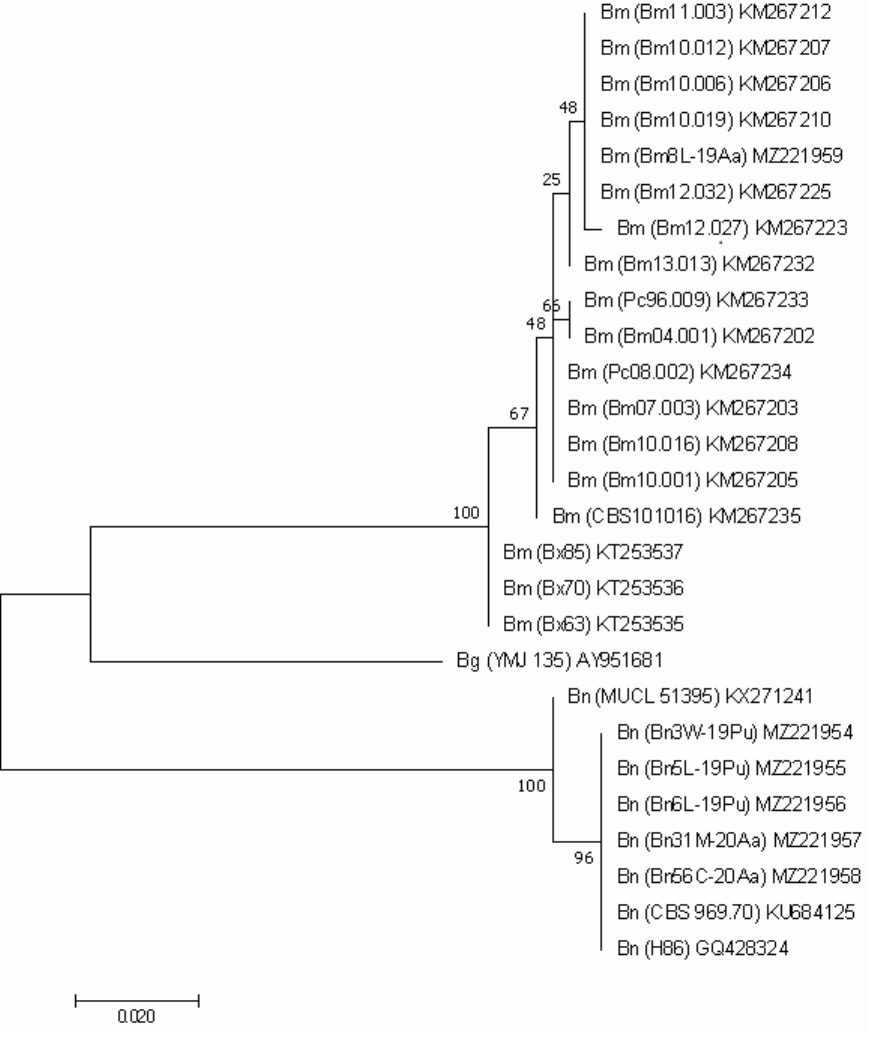
Figure 4. TUB2 -based phylogenetic tree of B. mediterranea (Bm) and B. nummularia (Bn) isolates produced using MEGAX. Additional sequence from B. granmoi (Bg) was included for additional comparison. Details on isolates are described in Table 3.